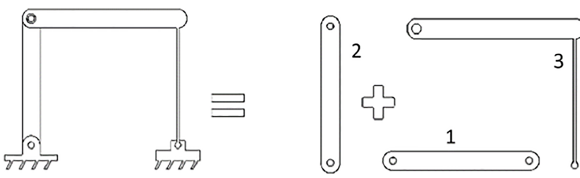
evaluated to obtain a satisfactory sweeping area. The orien- tation of the mechanism and the swept area are presented in Fig. 5. This process is also used for determining the wiper blade length and is selected as 70 cm.